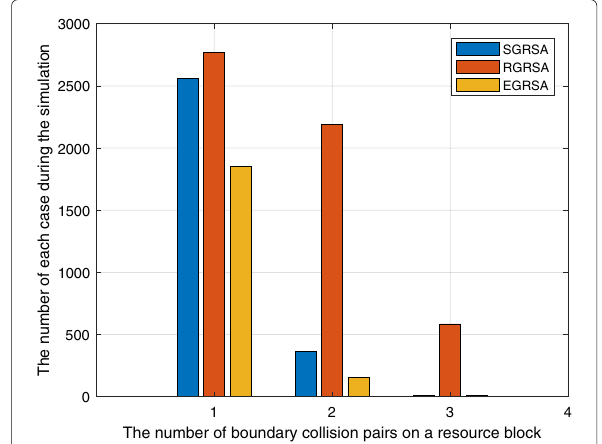
Fig. 13 The distribution of boundary collision pairs. The numbers on the horizontal axis indicate how many boundary collision pairs exist on a resource block. The vertical axis represents the number of each case whichoccurredduringthesimulation. Two geo-based algorithms, namely random geo-based resource selection algorithm (RGRSA) and sensing geo-basedresourceselectionalgorithm (SGRSA) in contribution [9] and [14], respectively, are selected as comparison schemes. The proposed enhanced geo-based resource selection algorithm (EGRSA) is indicated in yellow. The RGRSA and the SGRSA are indicated in orange and blue,